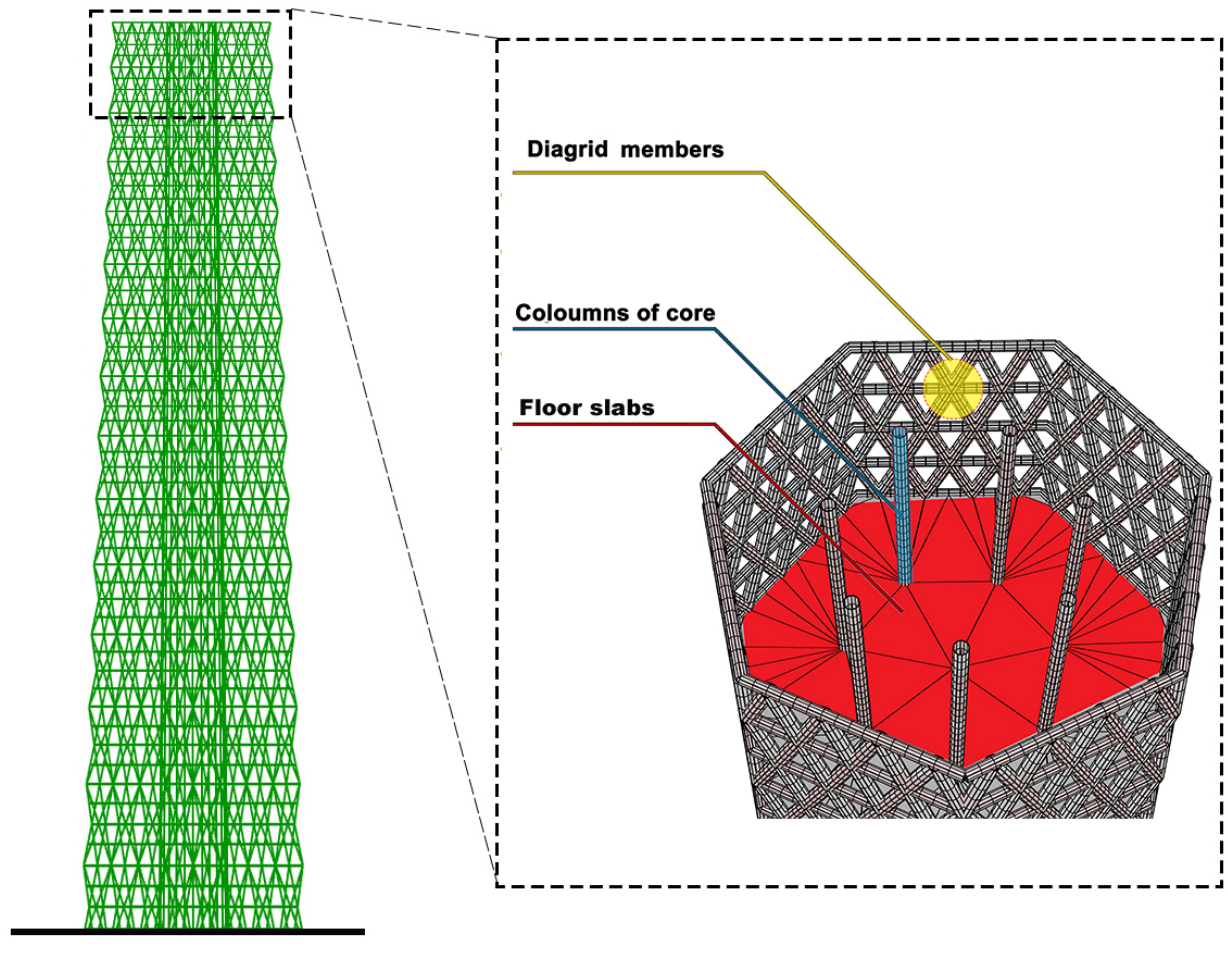
Figure 2. Tall building geometry with floor slabs and diagrid structure. In the inset: detail of the inner columns and of the diagrid geometry on the outer